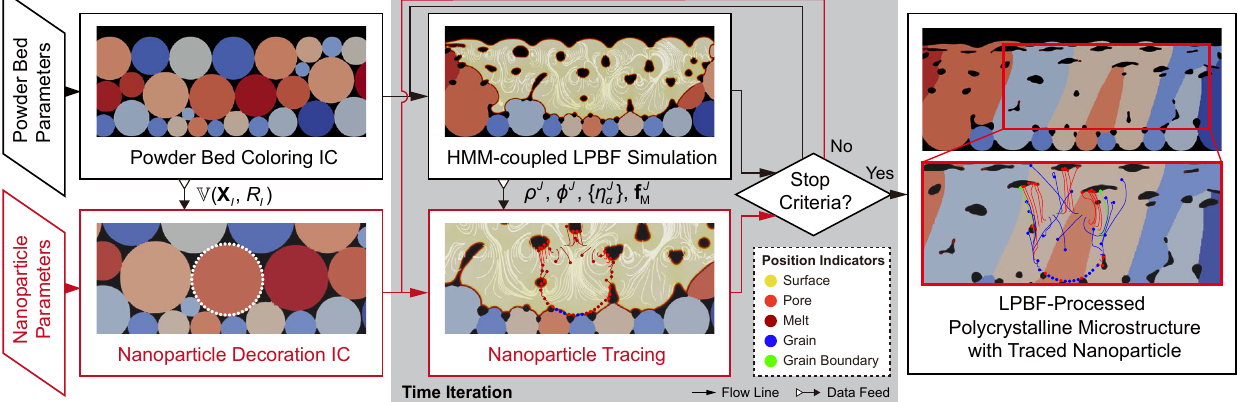
Figure 2. Workflow of the simulation scheme, including a phase-field simulation and a subsequent nanoparticle tracing